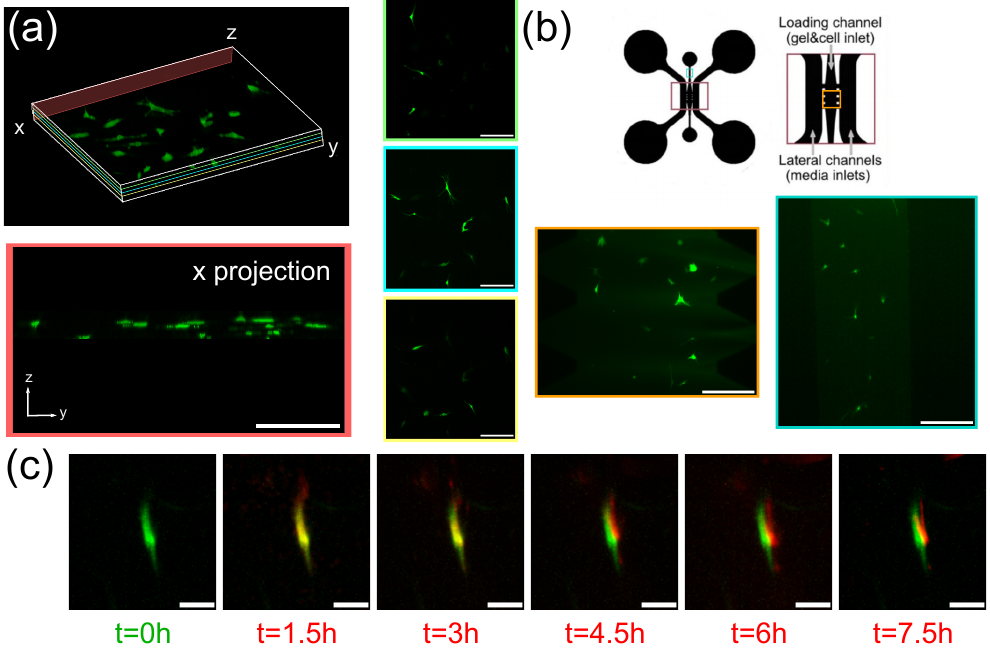
Figure 4. Skin dermal fibroblasts imaged growing in a plasma gel. ( a ) Volumetric reconstruction of fibroblasts embedded in a hydrogel acquired with the custom-made SPIM microscope. Three cross-sections in the xy plane are shown (green, blue and yellow) at different heights, as well as a projection in the x direction to show the relative z positions of the cells (red). Scale bars: 100 µ m; ( b ) Scheme of the microfluidic device where the fibroblasts are embedded with channels outlined. Fibroblasts are shown growing in the middle channel both at the entrance (blue) as well as in the middle region (orange). Scale bars: 200 µ m; ( c ) Time lapse of a fibroblast surveying its environment inside of the microfluidic channel with the initial position shown in green and successive positions shown in red. Scale bars: 20 µ m. All reconstructions were generated using the Fiji plugin Volume Viewer, with volume rendering using trilinear